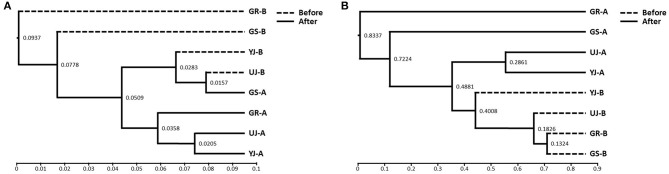
Hierarchical clustering analysis of (A) bacterial and (B) fungi communities in gochujang samples based on the unweighted pair group method with arithmetic mean (UPGMA).